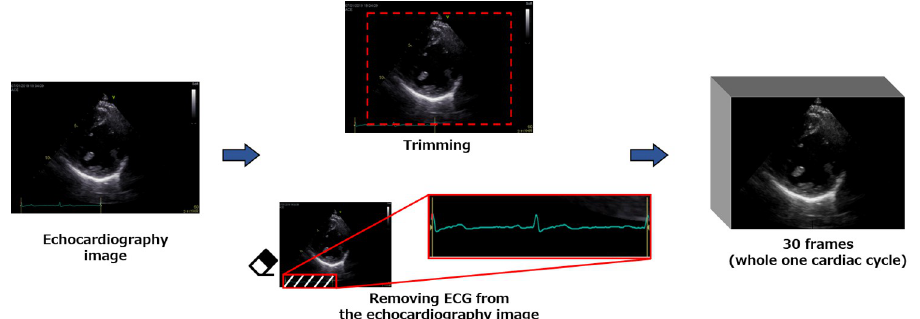
Fig 4. Preprocessing of the input data. All frames of one cardiac cycle taken from the original echocardiography image were interpolated to 30 frames, and the ECG in the image was removed and trimmed.